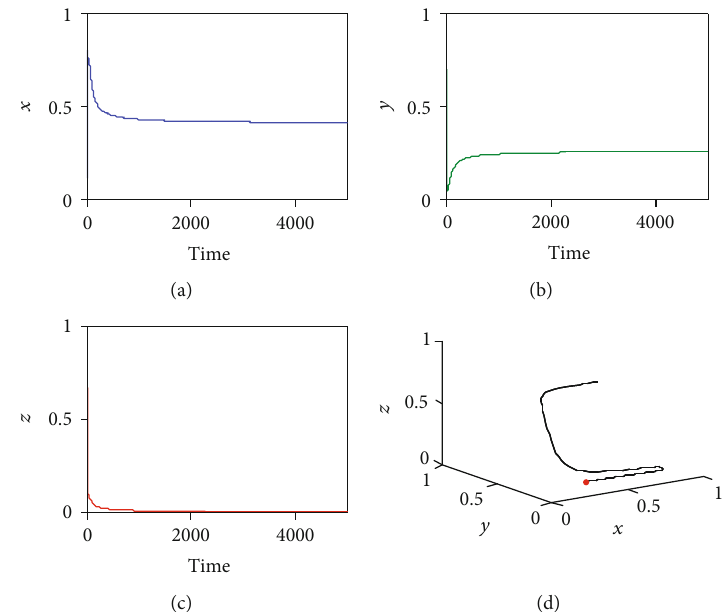
= 2 , with the data given by (89). (a) The trajectory of x versus t . (b) The trajectory of y versus t . (c) The trajectory of z versus Figure 2: For α 1 t . (d) The trajectory of system (4) approaches asymptotically to GPFP.